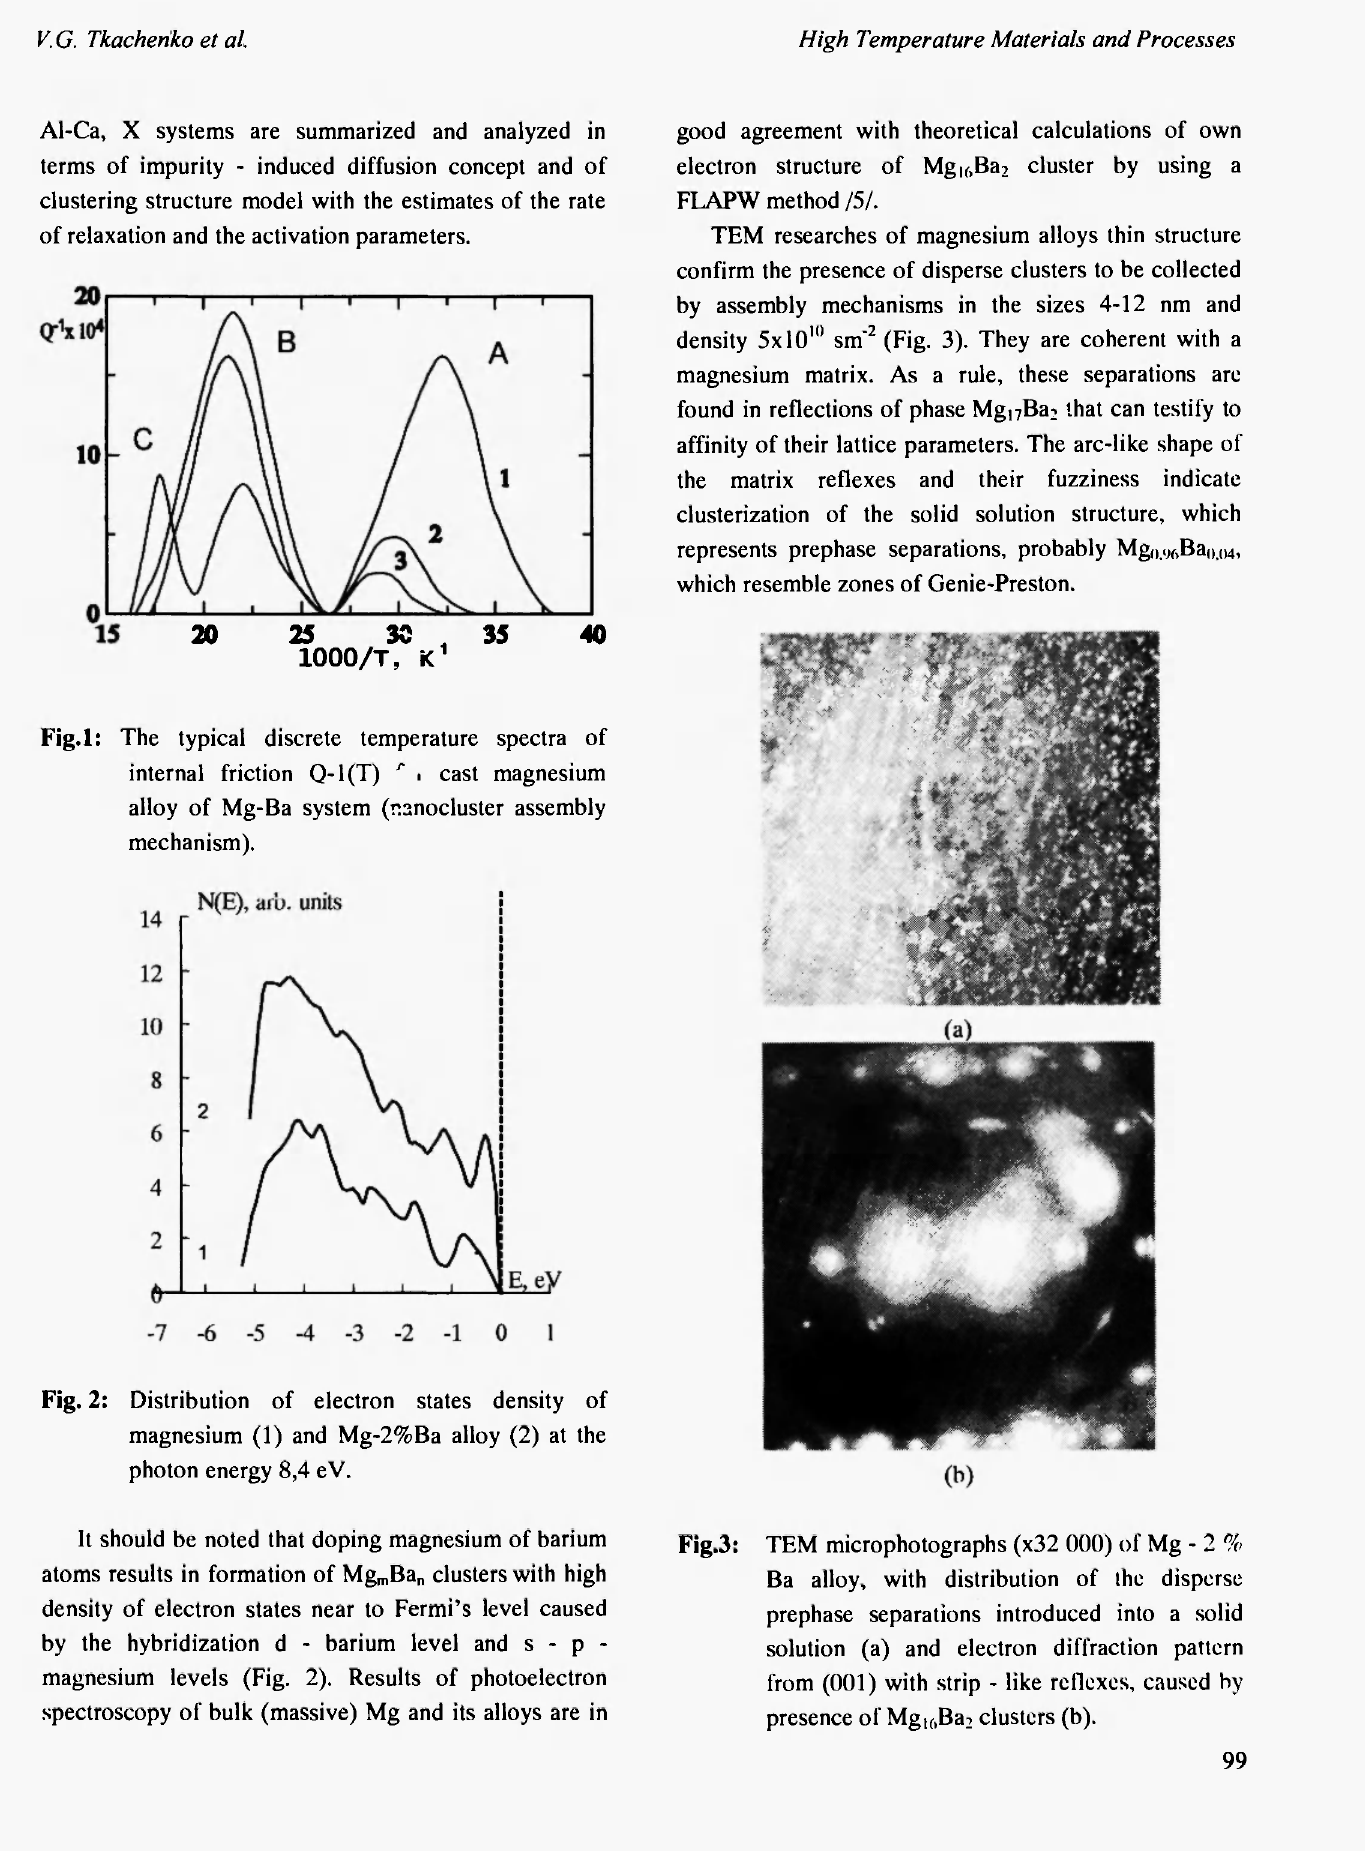
Fig. 2: Distribution of electron states density of magnesium (1) and Mg-2%Ba alloy (2) at the photon energy 8,4 eV.